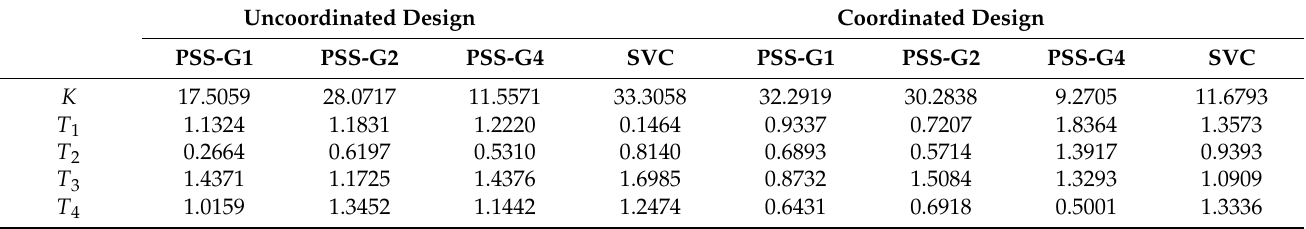
Table 14. Test system electromechanical modes and related damping ratios for different cases.